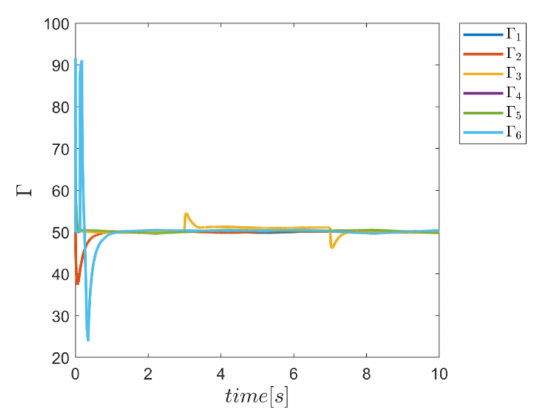
Figure 48. Adaptive variation of the coefficents of Γ for the combined α and Γ fuzzy system.